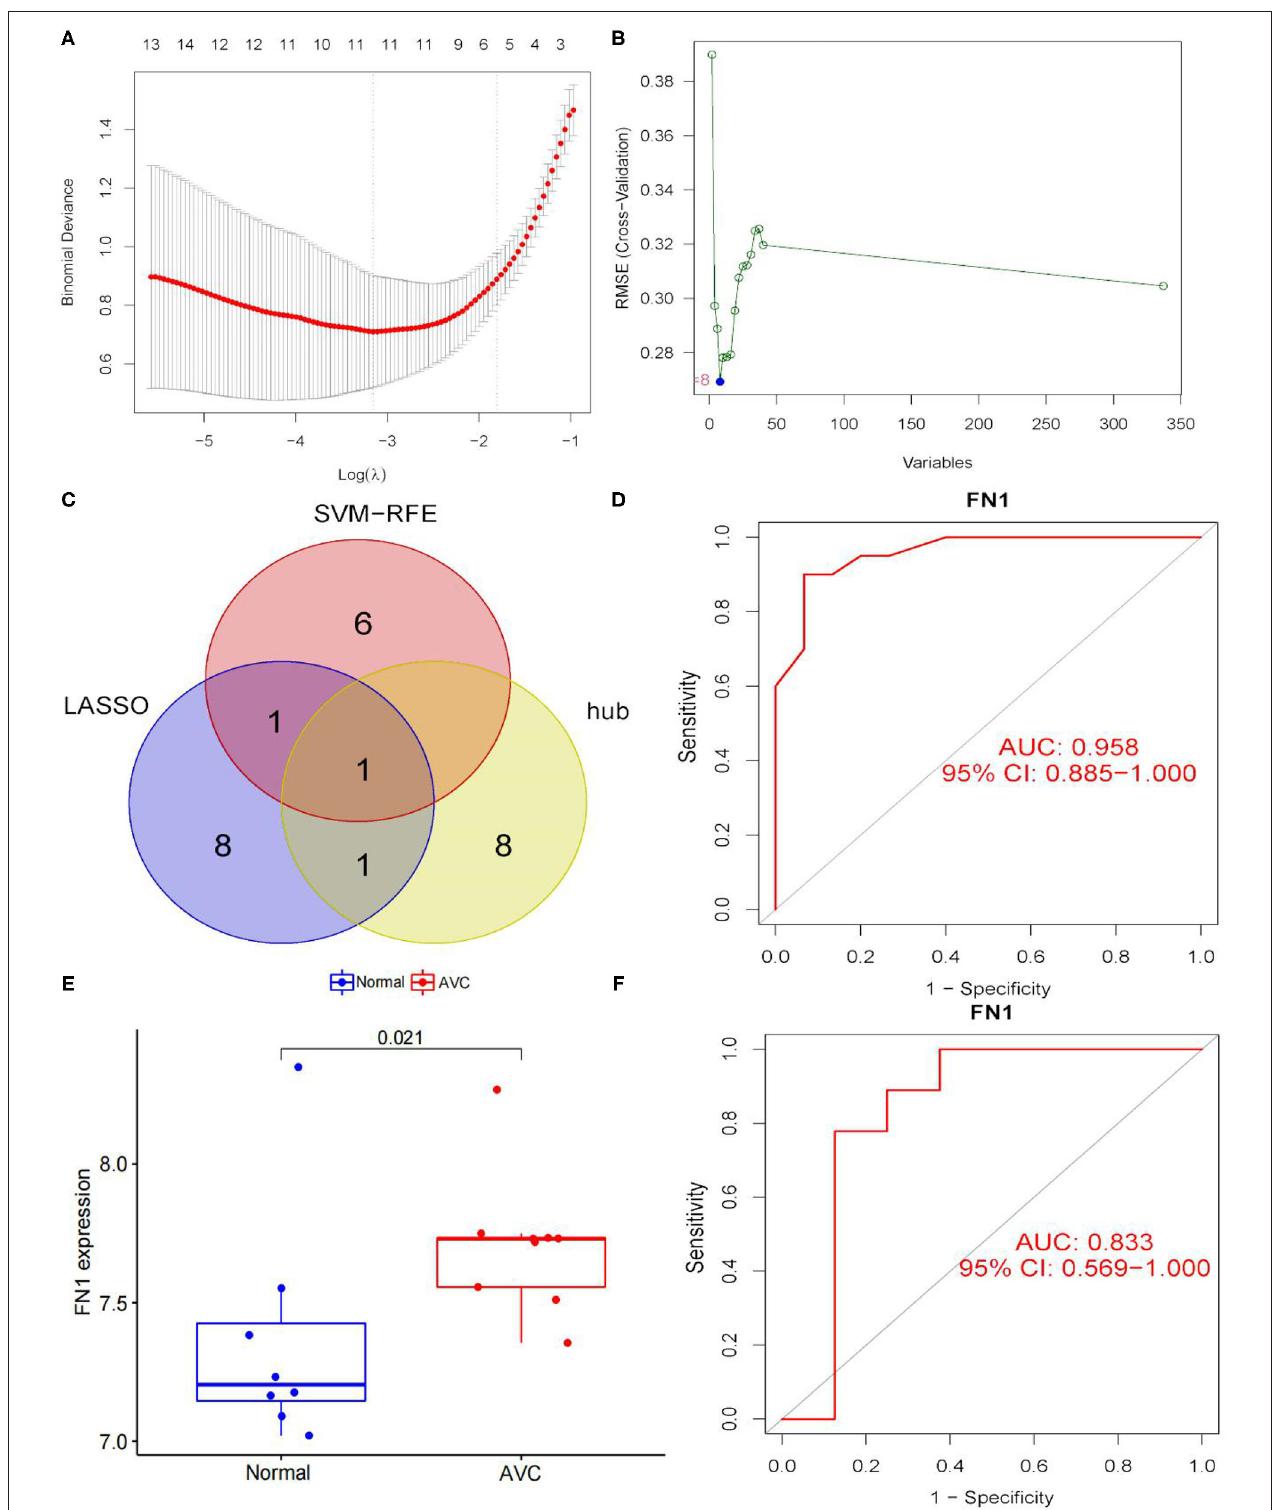
FIGURE 8 | Screening and verification of diagnostic markers. (A) Tuning feature selection in the least absolute shrinkage and selection operator (LASSO) model. The DEGs were narrowed down using the LASSO regression algorithm, resulting in the identification of 11 variables as diagnostic biomarkers for AVC. The ordinate is the value of the coefficient, the lower abscissa is log( λ ), and the upper abscissa is the number of non-zero coefficients in the model at this time. (B) A plot of biomarkers